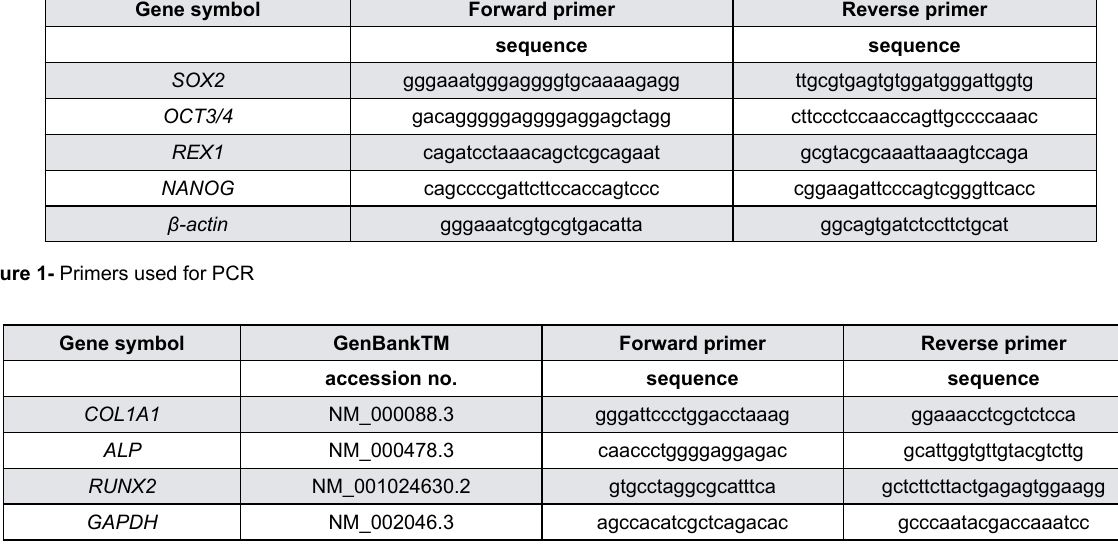
Figure 2- Primers used for